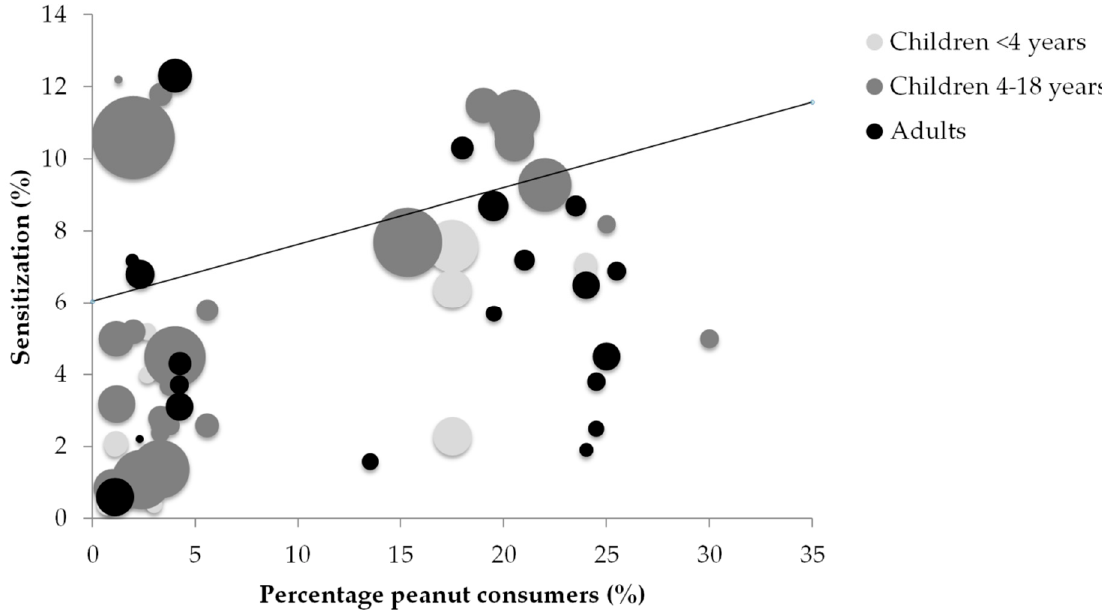
Figure 3. Relation between average peanut consumers (%) and reported peanut sensitization (%) in children <4 years; children 4–18 years; and adults, respectively. r values of respectively 0.673 ( p <